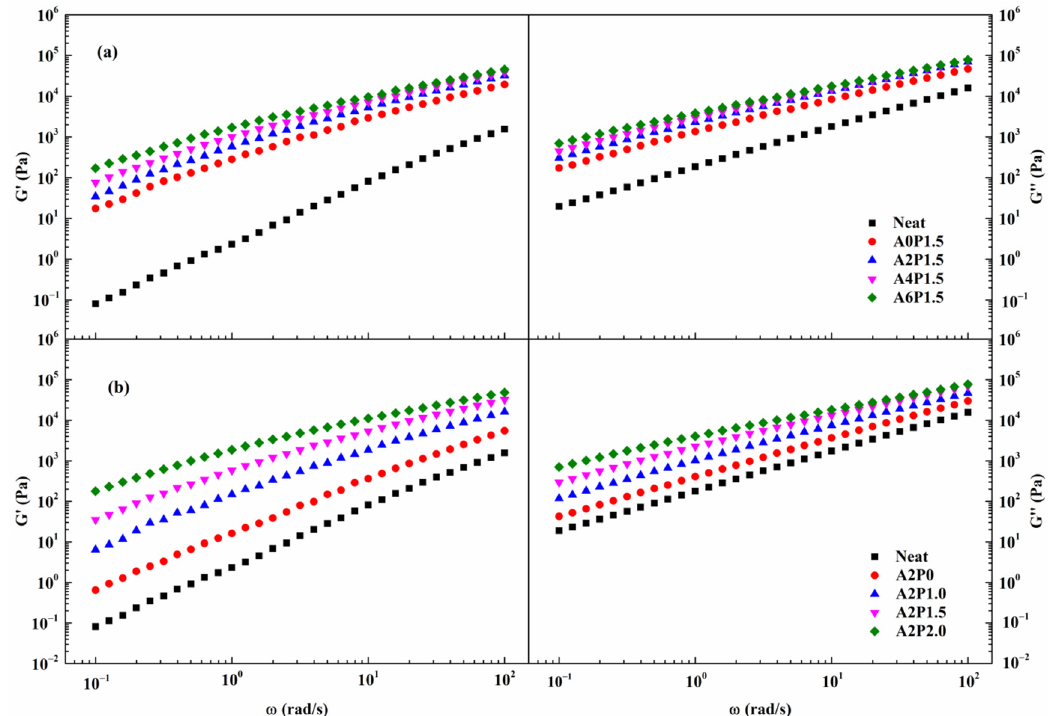
Figure 6. G ′ and G ″ variations with frequency for composite modified binders: ( a ) composite modified binders with various contents of APAO; ( b ) composite modified binders with various contents of PPA.